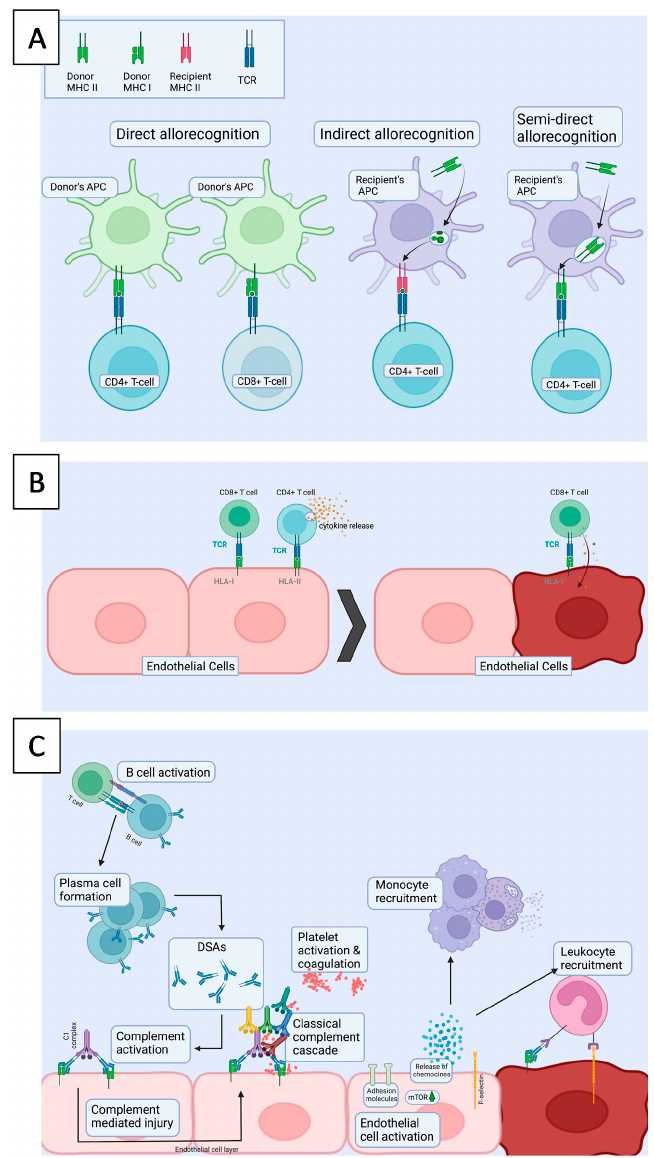
Figure 2. ( A ). Different T cell allorecognition pathways. In direct allorecognition, donor derived APCs present donor allopeptides on a donor MHC to the recipient’s T-cells, which leads to donor allorecognition. In indirect allorecognition, recipient derived APCs present a donor allopeptide on MHC molecule to the recipient’s T-cell. In semi-direct allorecognition, recipient APC catches a donor MHC molecule, which is transported to the cell surface and presented to T-cells. ( B ). In cellular rejection, alloreactive cytotoxic CD8+ T cells have been activated in secondary lymphoid organs by activated antigen presenting cells either via direct or indirect allorecognition. Once they encounter cells presenting target antigens on HLA I molecule, the target cells, which are typically ECs, will be killed. ( C ). AMR is characterized by injury of the allograft endothelium and presents as microvascular inflammation. First, donor derived antigen is presented by APCs to CD4+ T-cells in the secondary lymphoid organ. Hence, CD4+ T cells activate B cells and the formation of plasma cells,